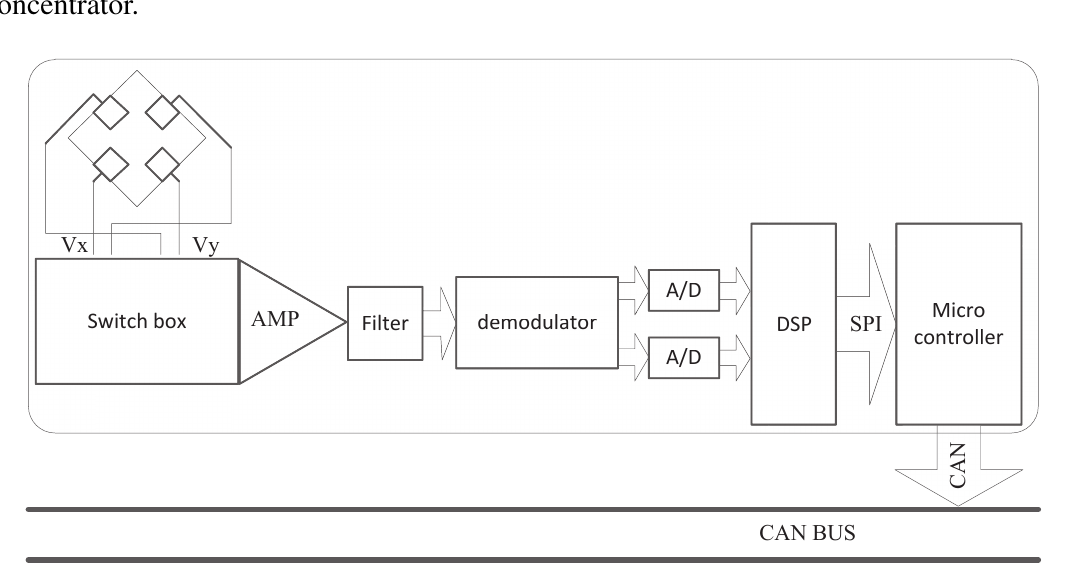
Figure 2. The constitution of the rotary encoder based on Hall plates with a magnetic